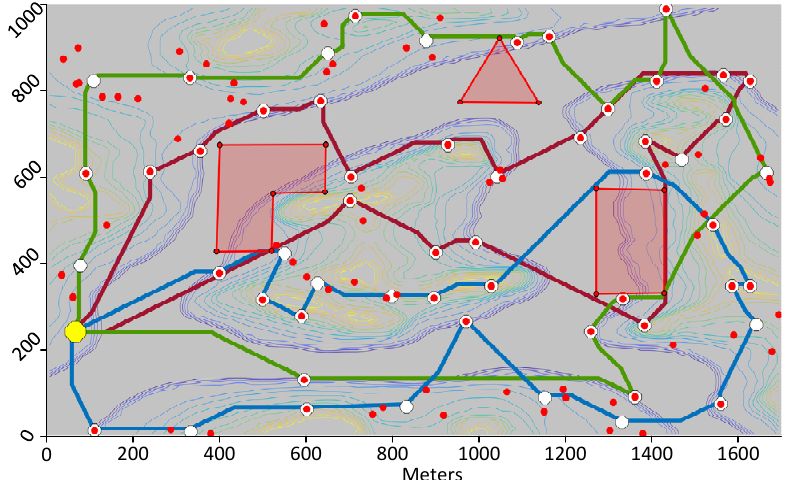
Figure 13. Paths minimizing distance for three UAVs visiting 55 download points covering 100 sensors.